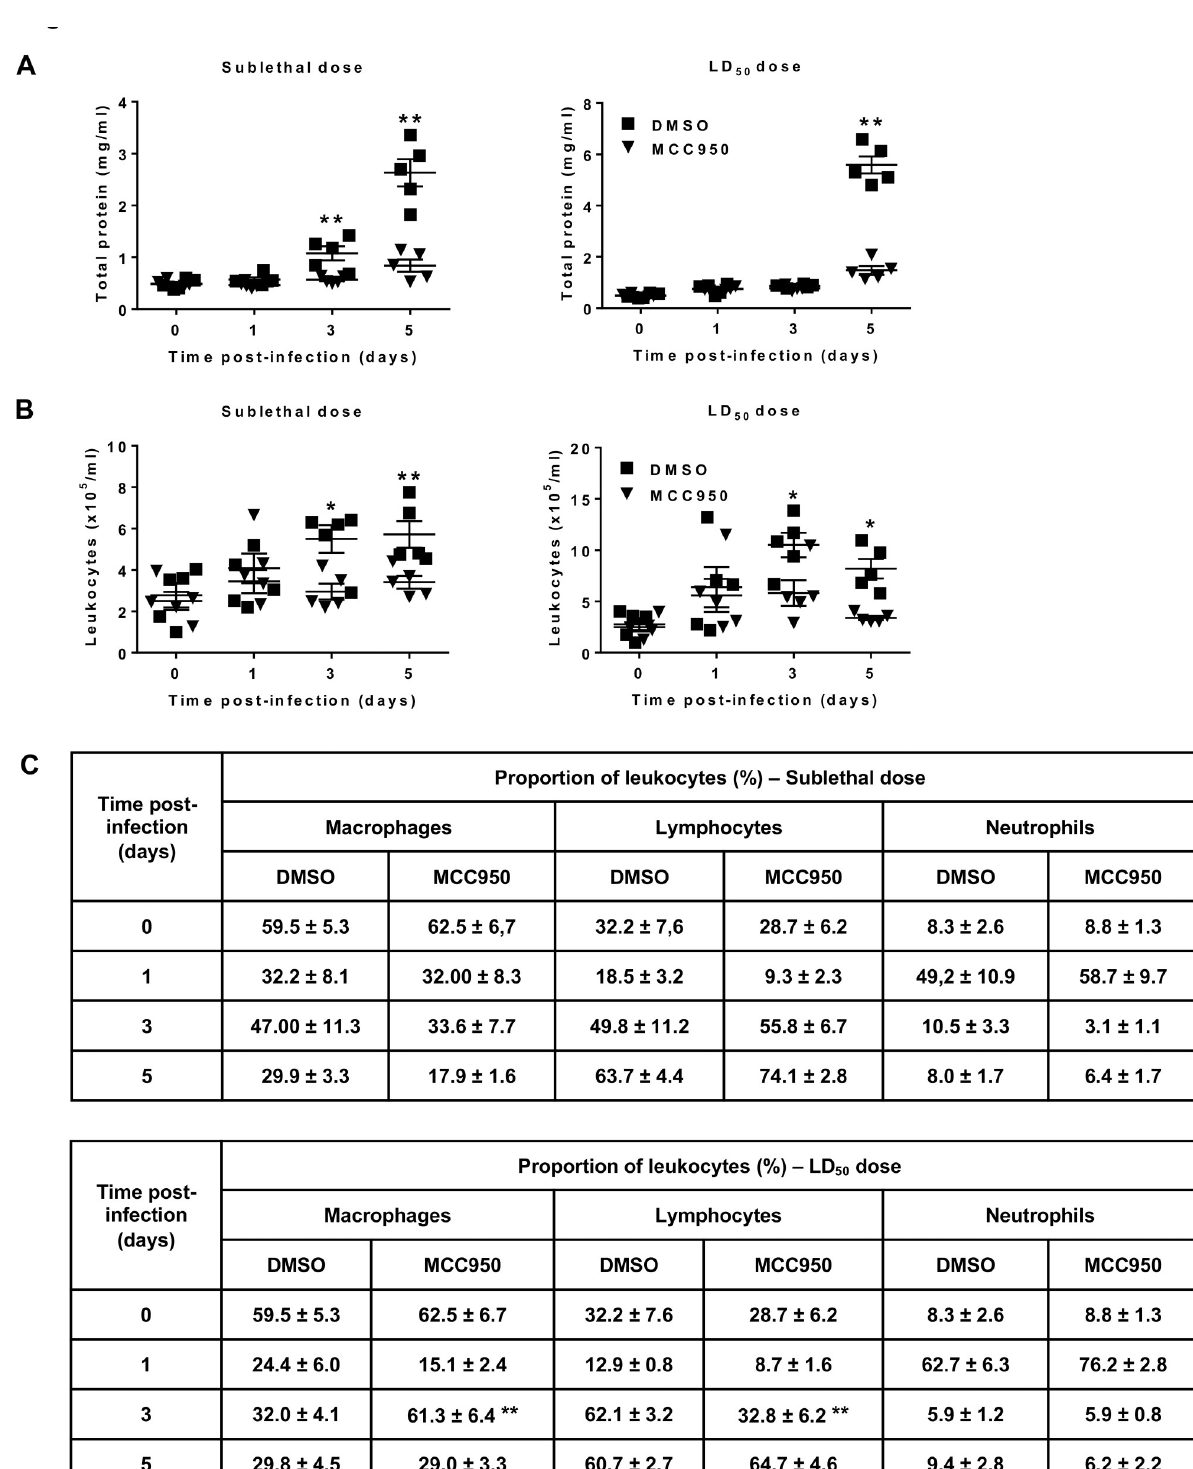
Fig 4. NLRP3 inflammasome contributes to inflammation in HMPV-infected mice. BALB/c mice were inoculated with HMPV at at sublethal (3 x 10 5 ) or LD 50 doses (5 x 10 5 PFU per mouse) in the presence or absence of MCC950 (5 mg/kg). MCC950 treatment was repeated for the next two days (1 time/day). (A) total protein, (B) leukocyte recruitment and (C) cell differentiation were evaluated in BAL. Values are shown as mean ± S.E.M (Mann-Whitney U-test, � P < 0.05; �� P < 0.01 MCC950 vs DMSO, n = 5 per group).